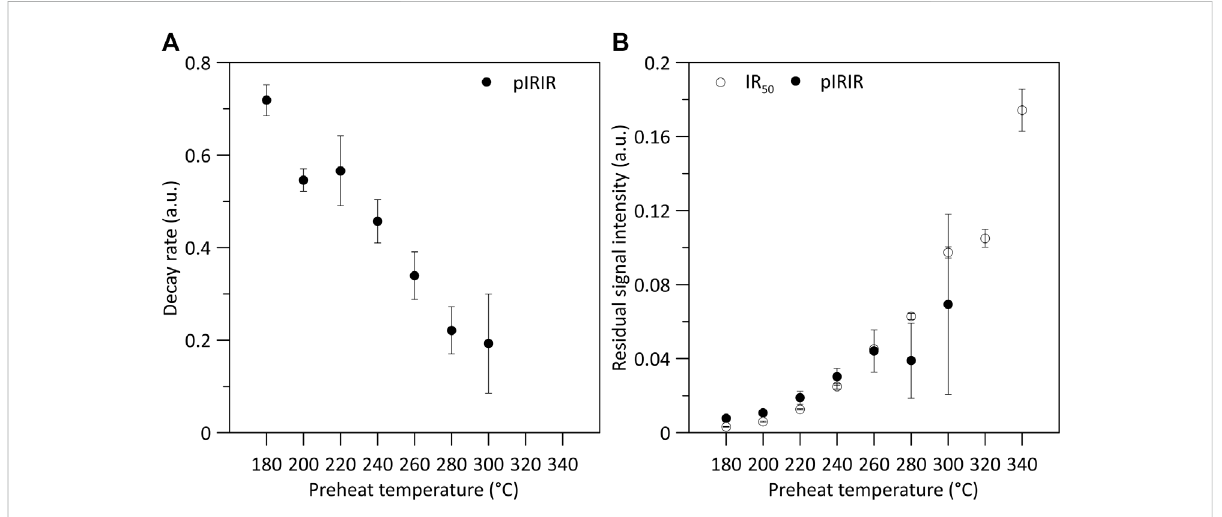
FIGURE 2 (A) The fi tted decay rate of pIRIR signals, and (B) relative residual intensity normalized to the natural signal for both IR 50 and pIRIR